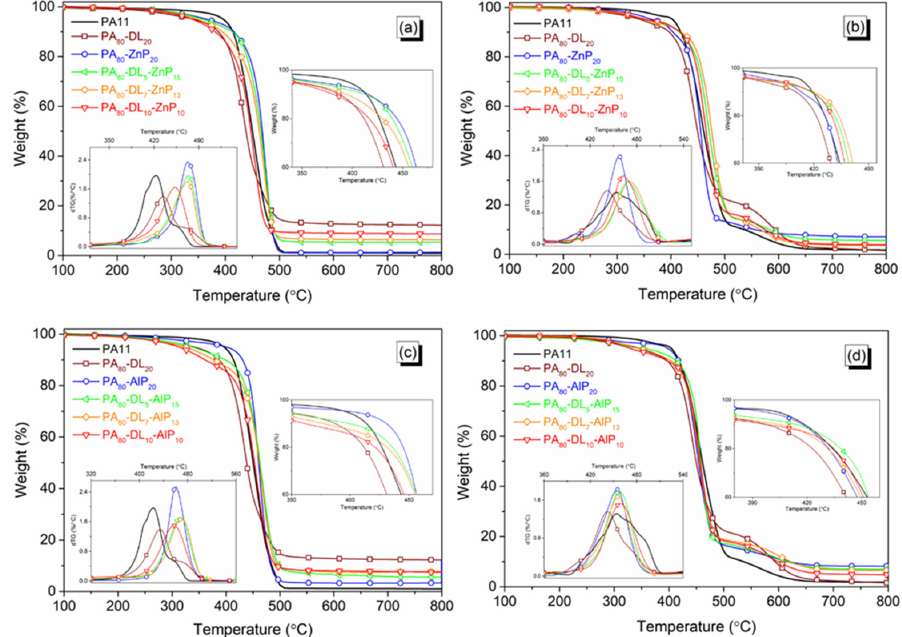
Figure 4. Thermogravimetric (TG) curves of polyamide 11 (PA11) blends of kraft lignin (DL) in combination with zinc phosphinate (ZnP) and aluminum phosphinate (AlP) in N 2 (( a ) and ( c )) and air atmosphere (( b ) and ( d )).